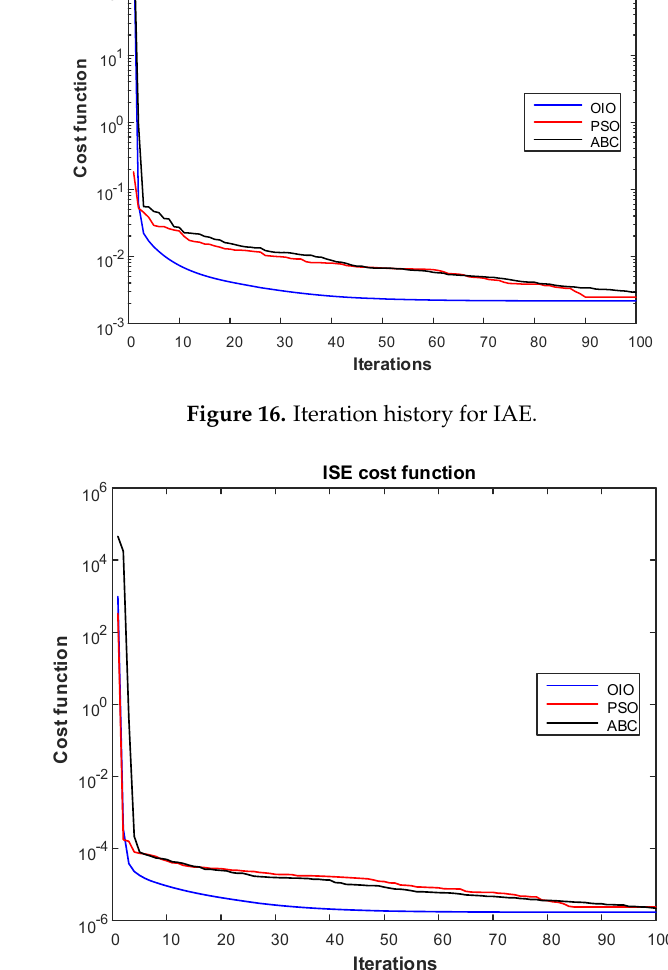
Table 5. Value of cost function for OIO, PSO, and ABC.